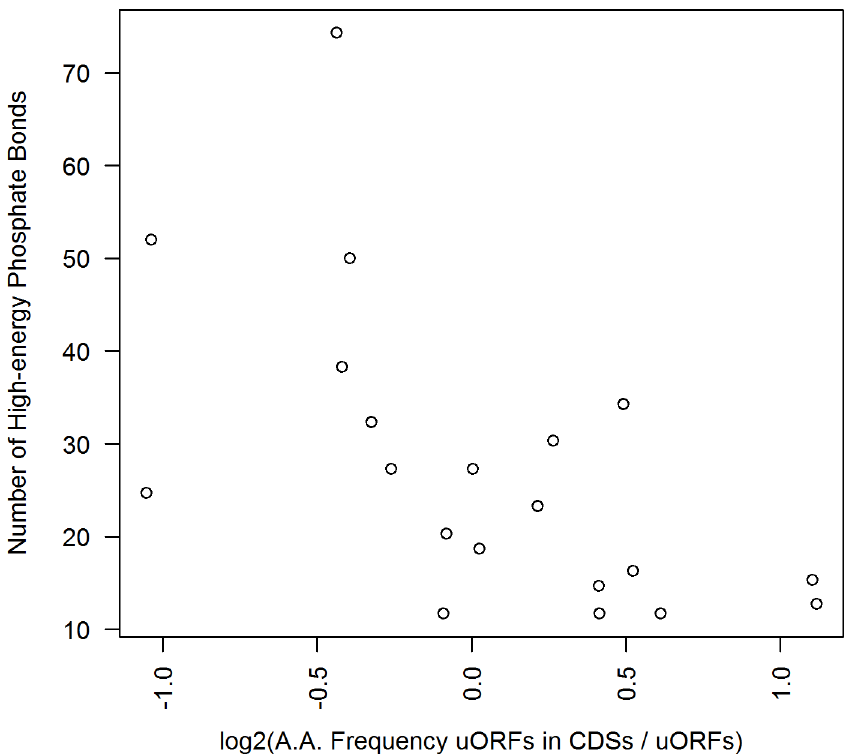
Fig 4. Amino acids with high energetic constraints are overrepresented in proximal uORFs. Each of the 20 proteinogenic amino acids is shown by a scatter plot. Positive x-values represent amino acids, which are contained more often in CDSs compared to proximal uORFs and vice versa. Generally, metabolically costly amino acids are used more frequently throughout proximal uORFs. (n prox.uORFs =